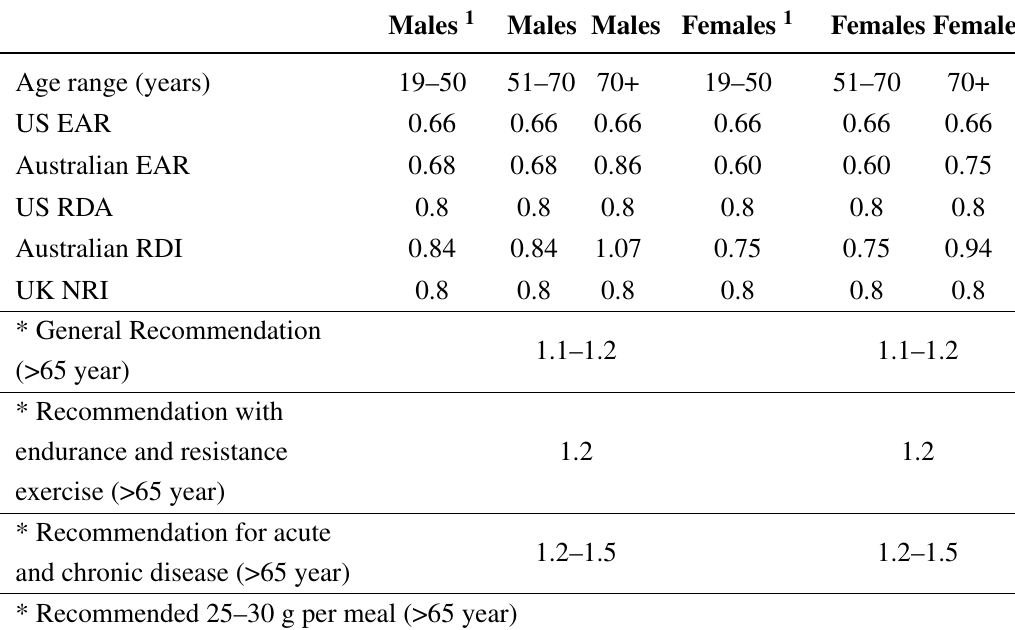
Nutrient reference intakes and recommended dietary intakes/allowances and proposed recommended protein intakes for older people